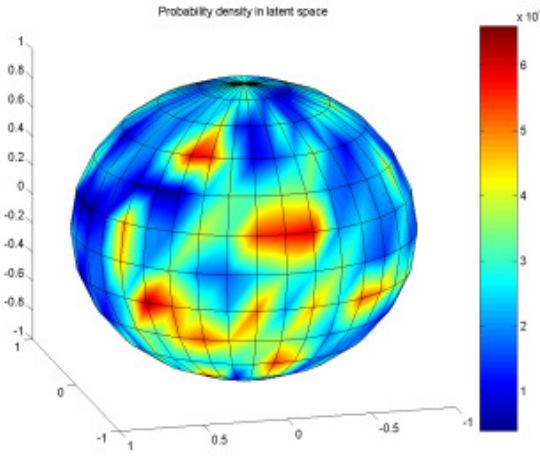
Figure 1. Latent variable responsibilities onto the spherical latent space. Note how the red areas correspond to higher density locations.